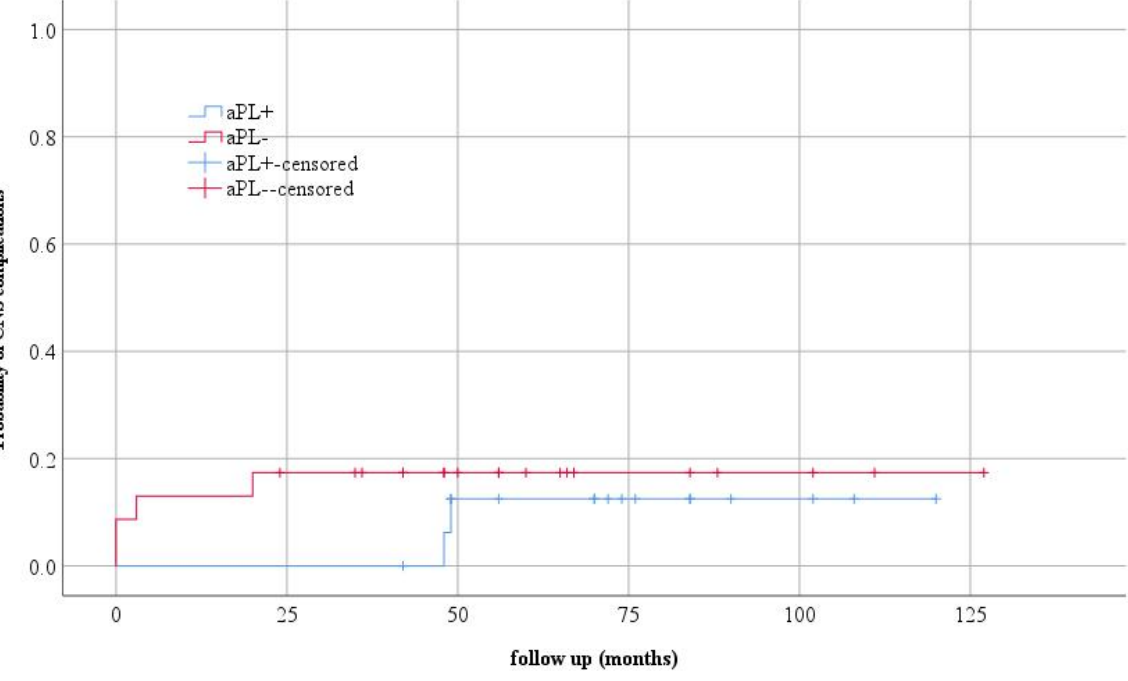
Figure 2. The probability of the occurrence of CNS complications and the clinical form of the dis- ease.